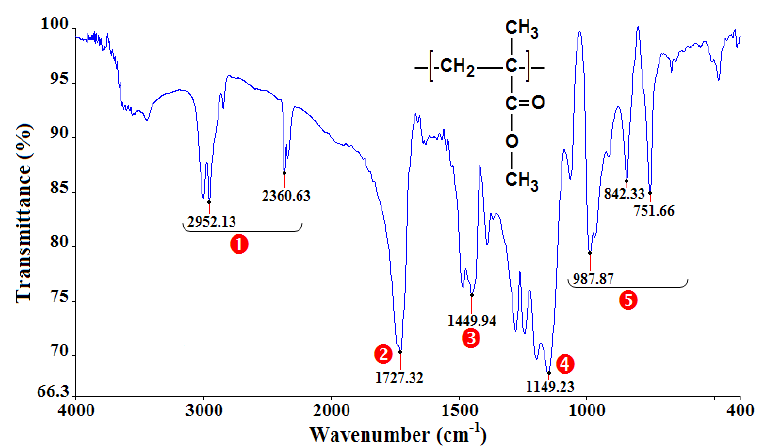
Figure 1. Infrared spectra of PMMA.